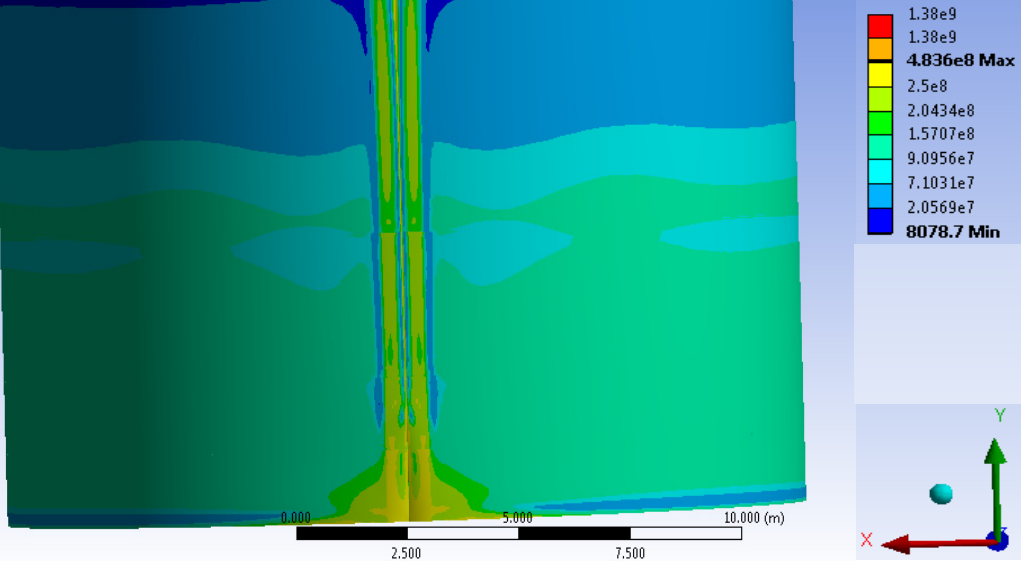
Figure 17. Distribution of equivalent stresses in the field joint zone with the joint imperfection at a = 50 cm; f = 10 cm.